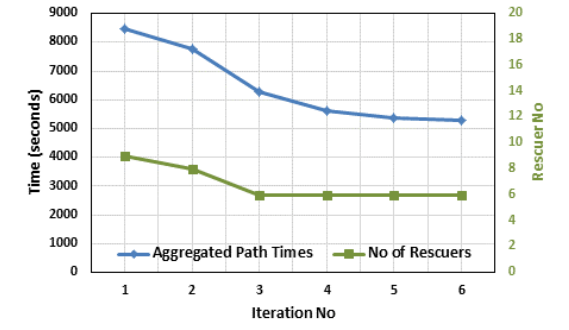
Figure 6. Finding minimum no. of rescuers and time during the iterations